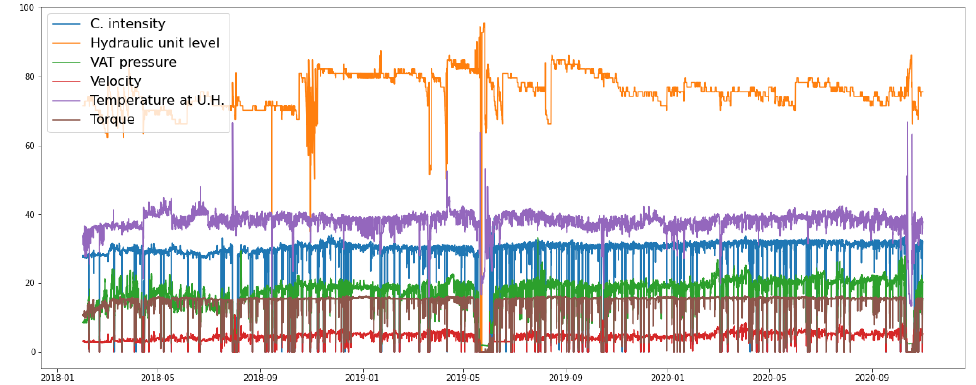
Figure 3. Plot of the sensor variables before applying data cleaning treatment. Many extreme values are visible for many variables, namely the hydraulic oil level and temperature.